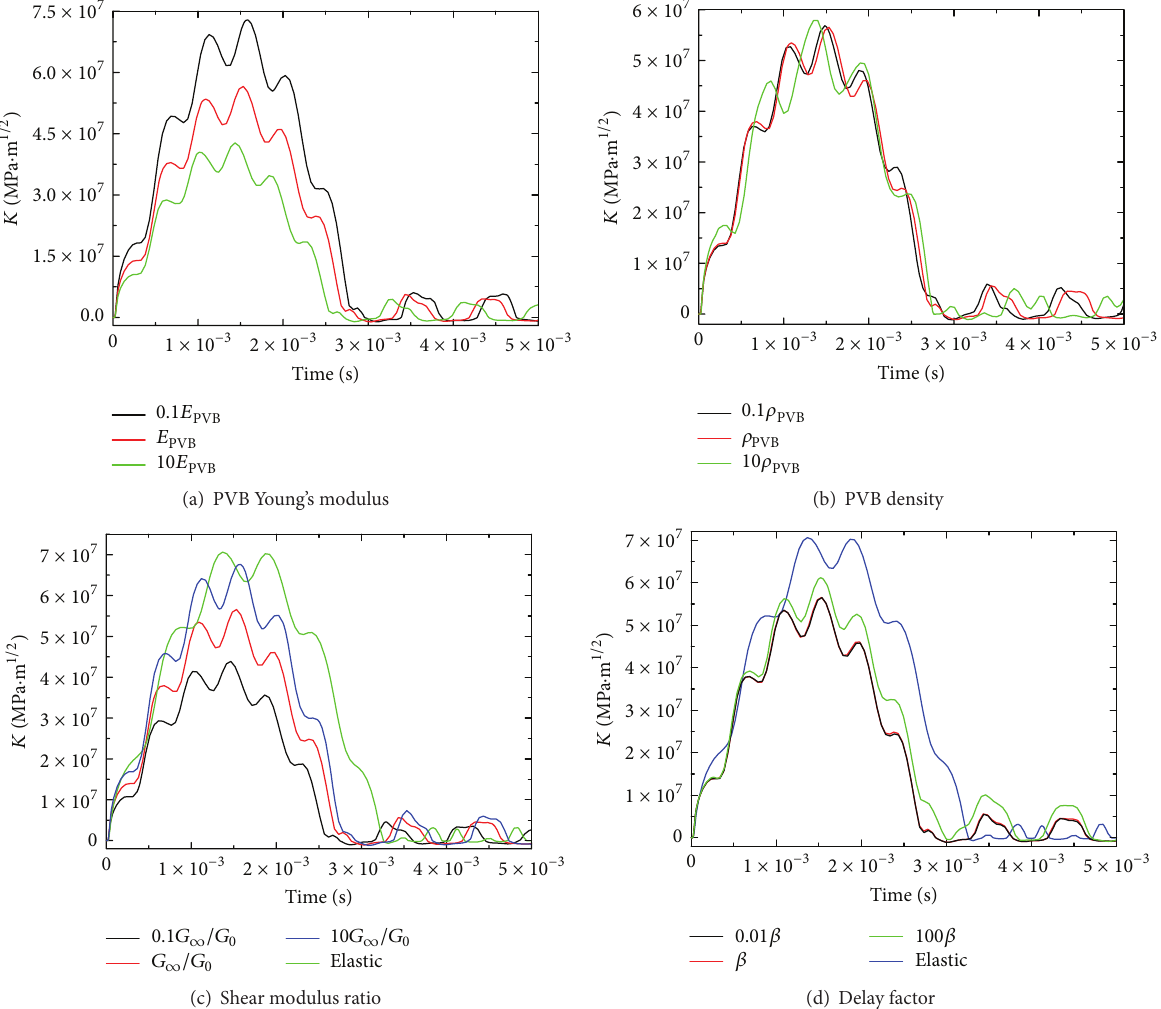
Figure 14: Mode I DSIF at node 1 of different PVB properties with the impact velocity of 5m/s and crack length of 0.02